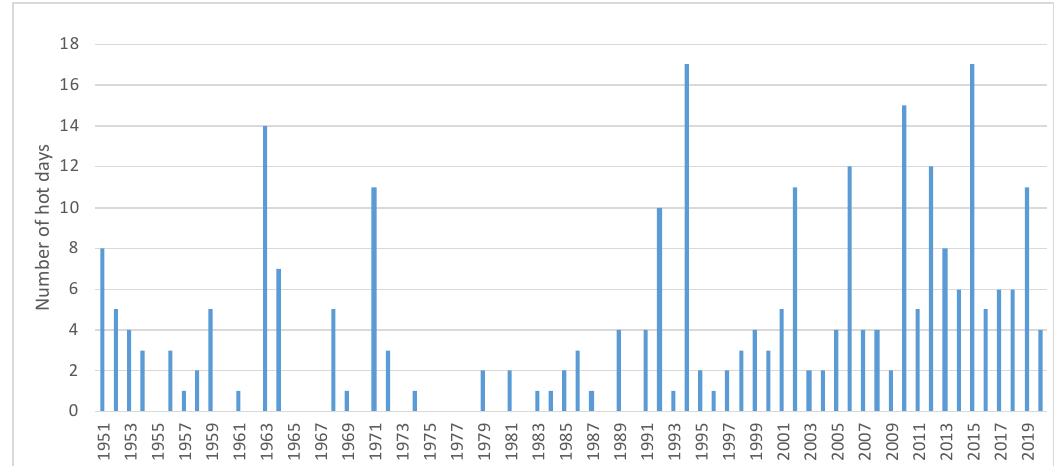
Figure 8. Number of hot days (with temperatures above 30 degrees Celsius) at the Białystok weather station. The minimum (NQ), maximum (WQ), and average (SQ) annual flows for the period 1951–2020 are presented in Figure 9. The minimum and average flows show a statistically insignificant decreasing trend (Table 1), with record-low values in 2019 and 2020 (Figure 9). However, the maximum annual flows show a decrease in the statistically significant direction (alpha = 0.05) (Table 1). The reasons for the visible change should be sought in